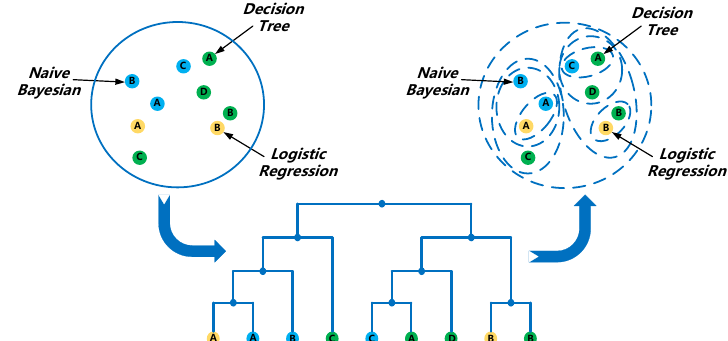
Figure 8. Hierarchical clustering process diagram.